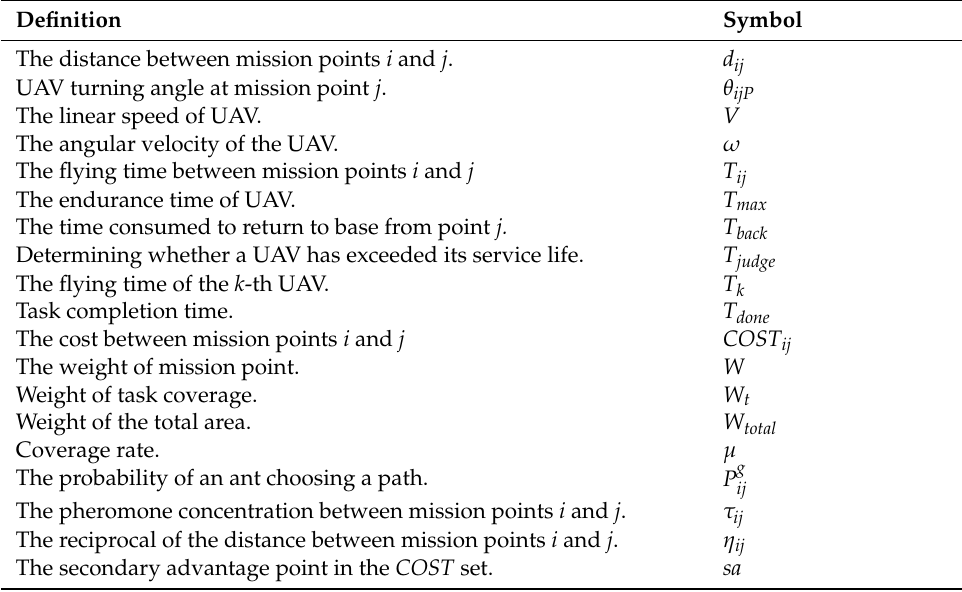
Table 2. Main parameters of this